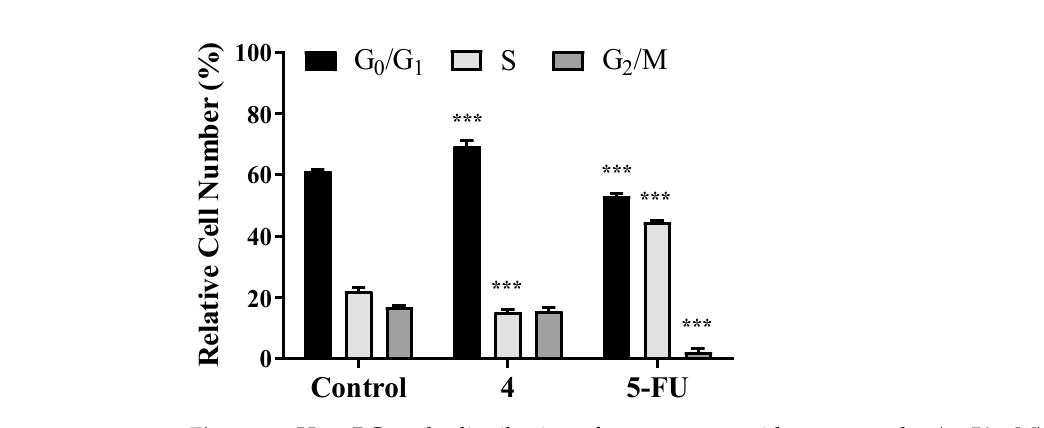
Figure 5. Microscopic visualization of HepaRG cells ( A ), control treated with compound 4 ( B ), compound 5 ( C ), and 5-fluorouracil ( D ) at 50 µM for 24 h. Amplification of 100×.